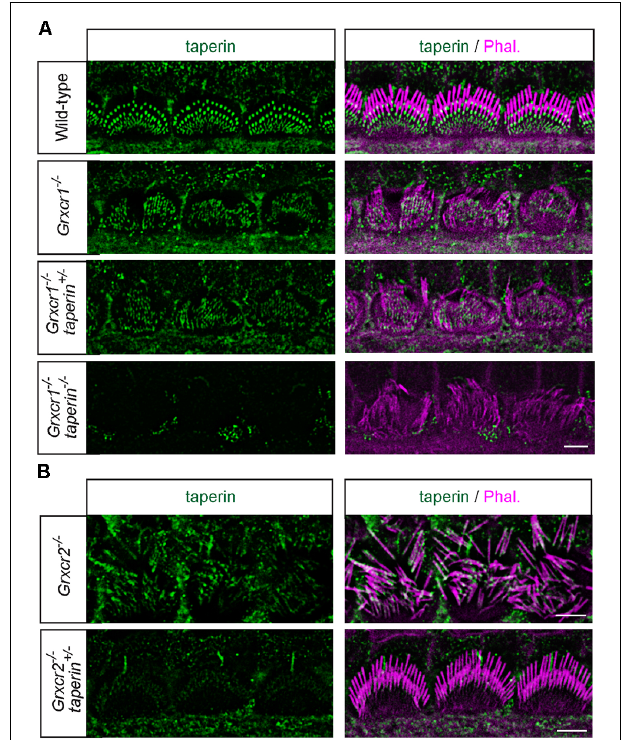
FIGURE 4 | Analysis of stereocilia morphology by immunostaining. (A) Whole mounts from the middle region of the cochlea from wild-type, Grxcr1 − / − , Grxcr1 − / − taperin + / − , and Grxcr1 − / − taperin − / − mice at the age of P7 were stained with taperin-antibody (green) and phalloidin (magenta). Note the disorganized stereocilia in Grxcr1 − / − , Grxcr1 − / − taperin + / − , and Grxcr1 − / − taperin − / − mice. (B) Whole mounts from the middle region of cochlea from Grxcr2 − / − and Grxcr2 − / − taperin + / − mice at the age of P7 were stained with taperin-antibody and phalloidin. Note the disorganized stereocilia in Grxcr2 − / − mice and well-maintained stereocilia in Grxcr2 − / − taperin + / − mice. Scale bars: 5 µ